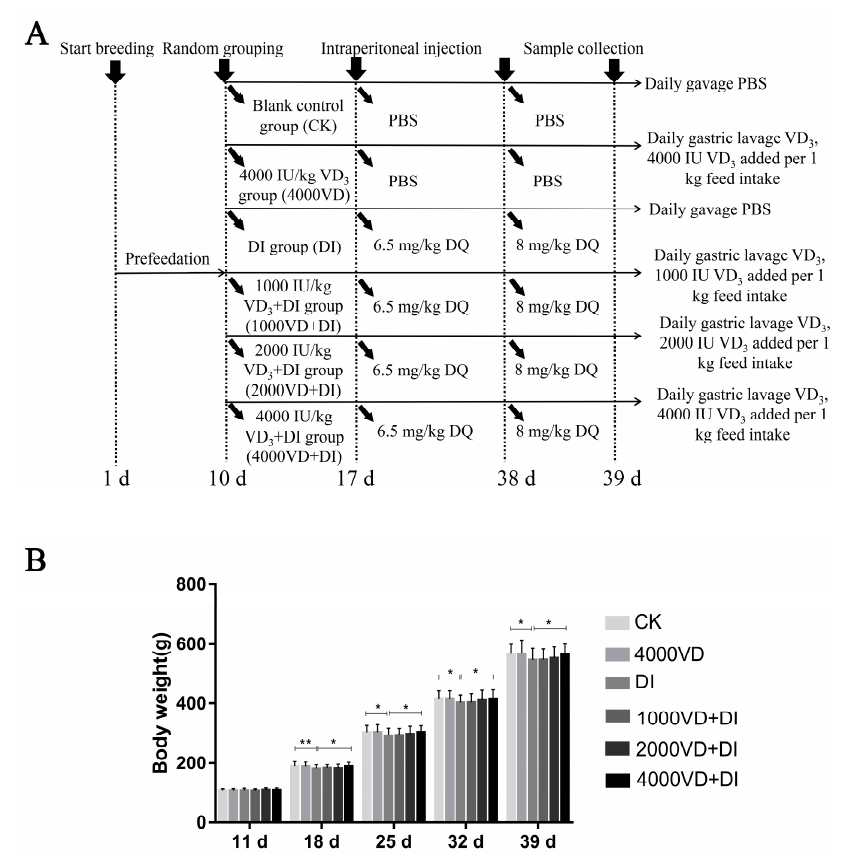
Figure 1. ( A ) Experimental treatment diagram of each group and ( B ) the effect of different supplemental levels of VD 3 on the body weight of the Wenchang chicken oxidative stress model. (Statistical analysis of the data was performed using the Duncan method to analyze the significance of differences between samples by IBM SPSS software, * p < 0.05, ** p < 0.01). Table 1. Basal diet composition and its nutrient level (air-dried basal) (%).